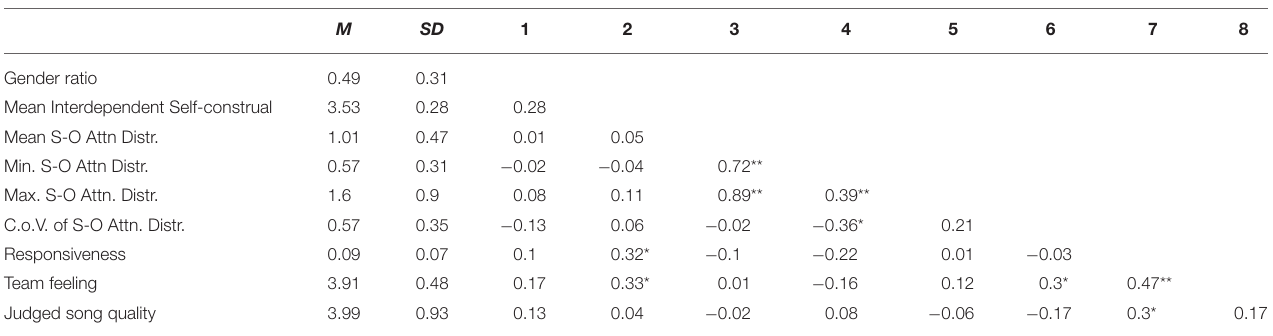
TABLE 2 | Means, standard deviations, and